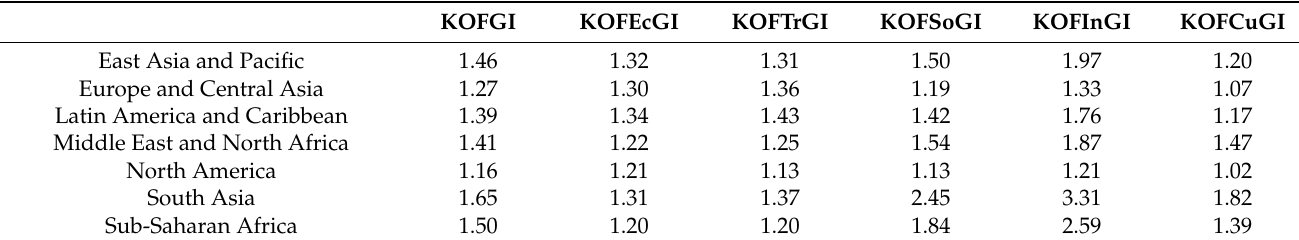
Table 2. Comparative analysis of globalisation process intensity by continents and regions.